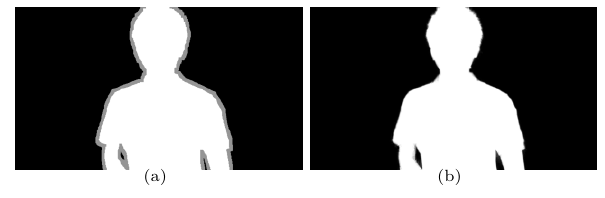
Fig. 2 (a) Automatically generated trimap. (b) Alpha matting result.